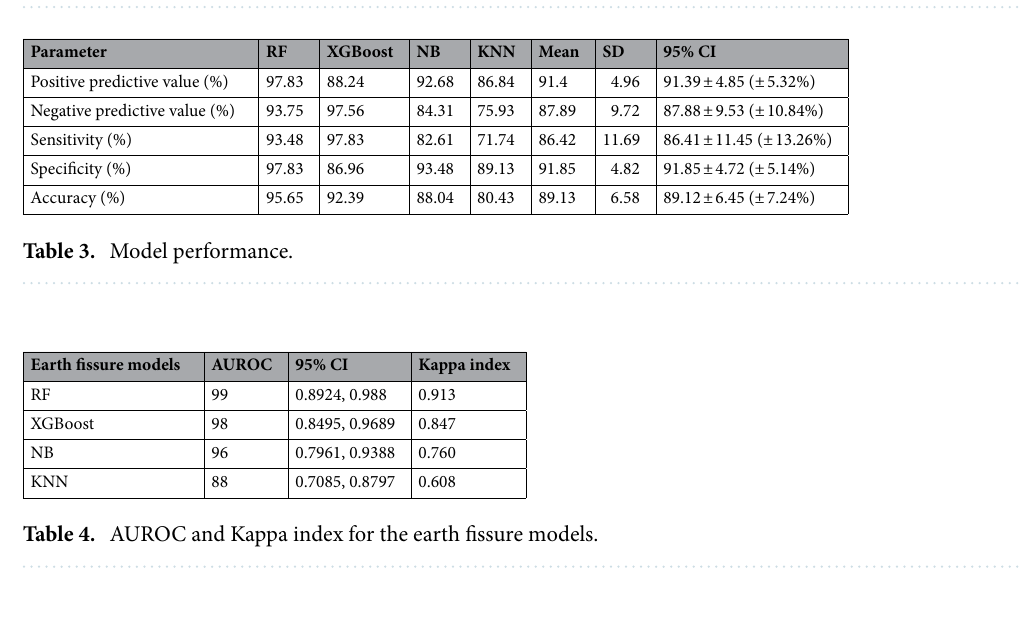
Figure 9. ROC curve showing AUC values of RF, XGBoost, NB and KNN (Developed by the first author using R studio software (v. 3.6.1).